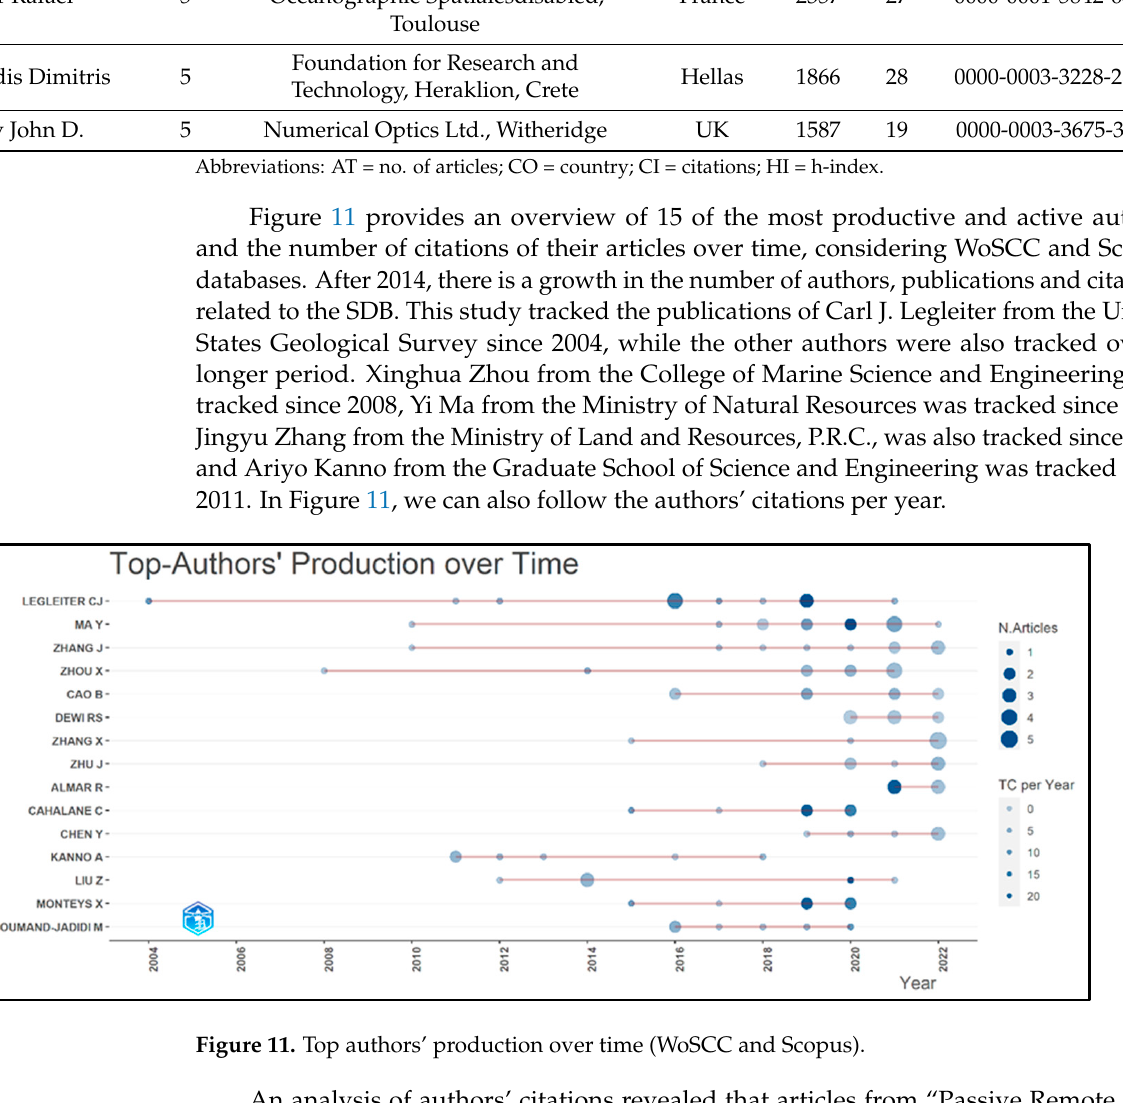
Figure 12. Ten most globally cited authors by WoS and Scopus databases.